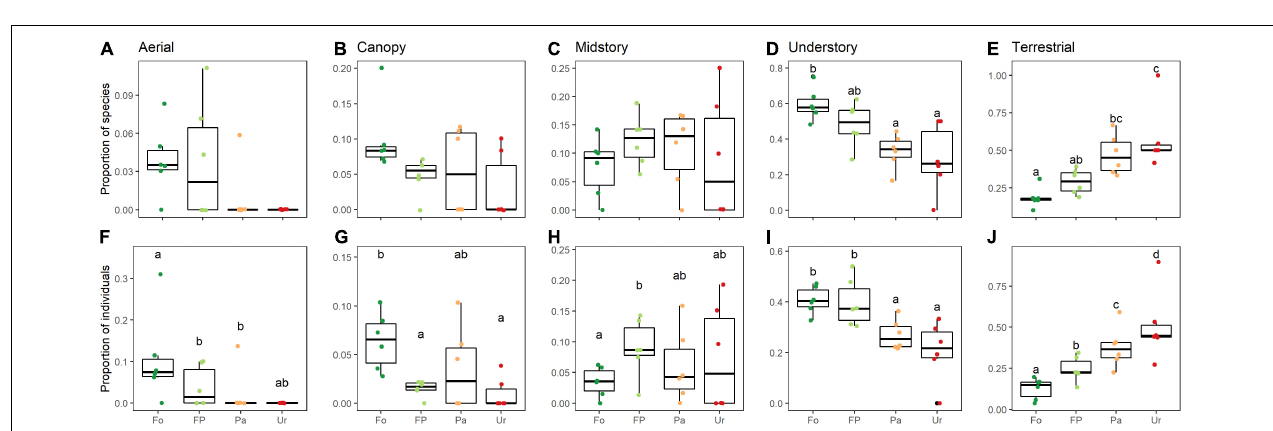
FIGURE 4 | Land-use effects on richness (A–D) and abundance (E–H) of bird trophic guilds along an urbanization gradient in the southern Ecuadorian Andes. Carnivore (A) , frugivore (B) , granivore (C) , insectivore (D) , nectarivore (E) , and omnivore (F) birds. Data is depicted through quartiles and different lowercase letters above (or below) the whiskers indicate significant differences between land uses (GLM p < 0.05). Fo, forest sites; FP, forest-pasture sites; Pa, pasture sites; Ur, urban sites.